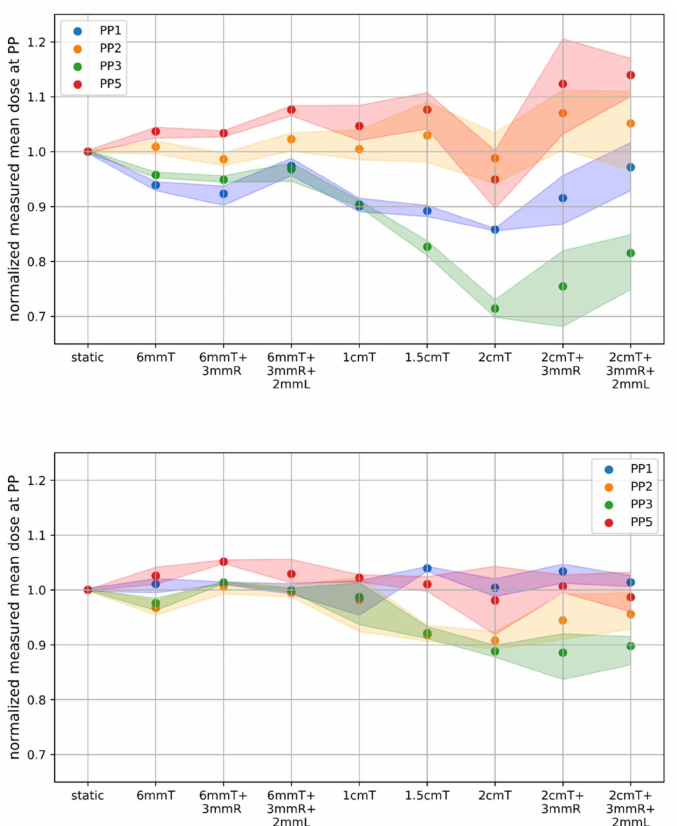
Figure 3. Normalized carbon ion ( upper ) and proton ( lower ) dose at [PP1-3,5] for the different motion scenarios during one measurement day. The different colours represent the different PinPoint chambers. The shaded area around the points shows the maximum and minimum within the scenarios for the repeated measurements. T = tumour movement, R = rib movement, and L = lung